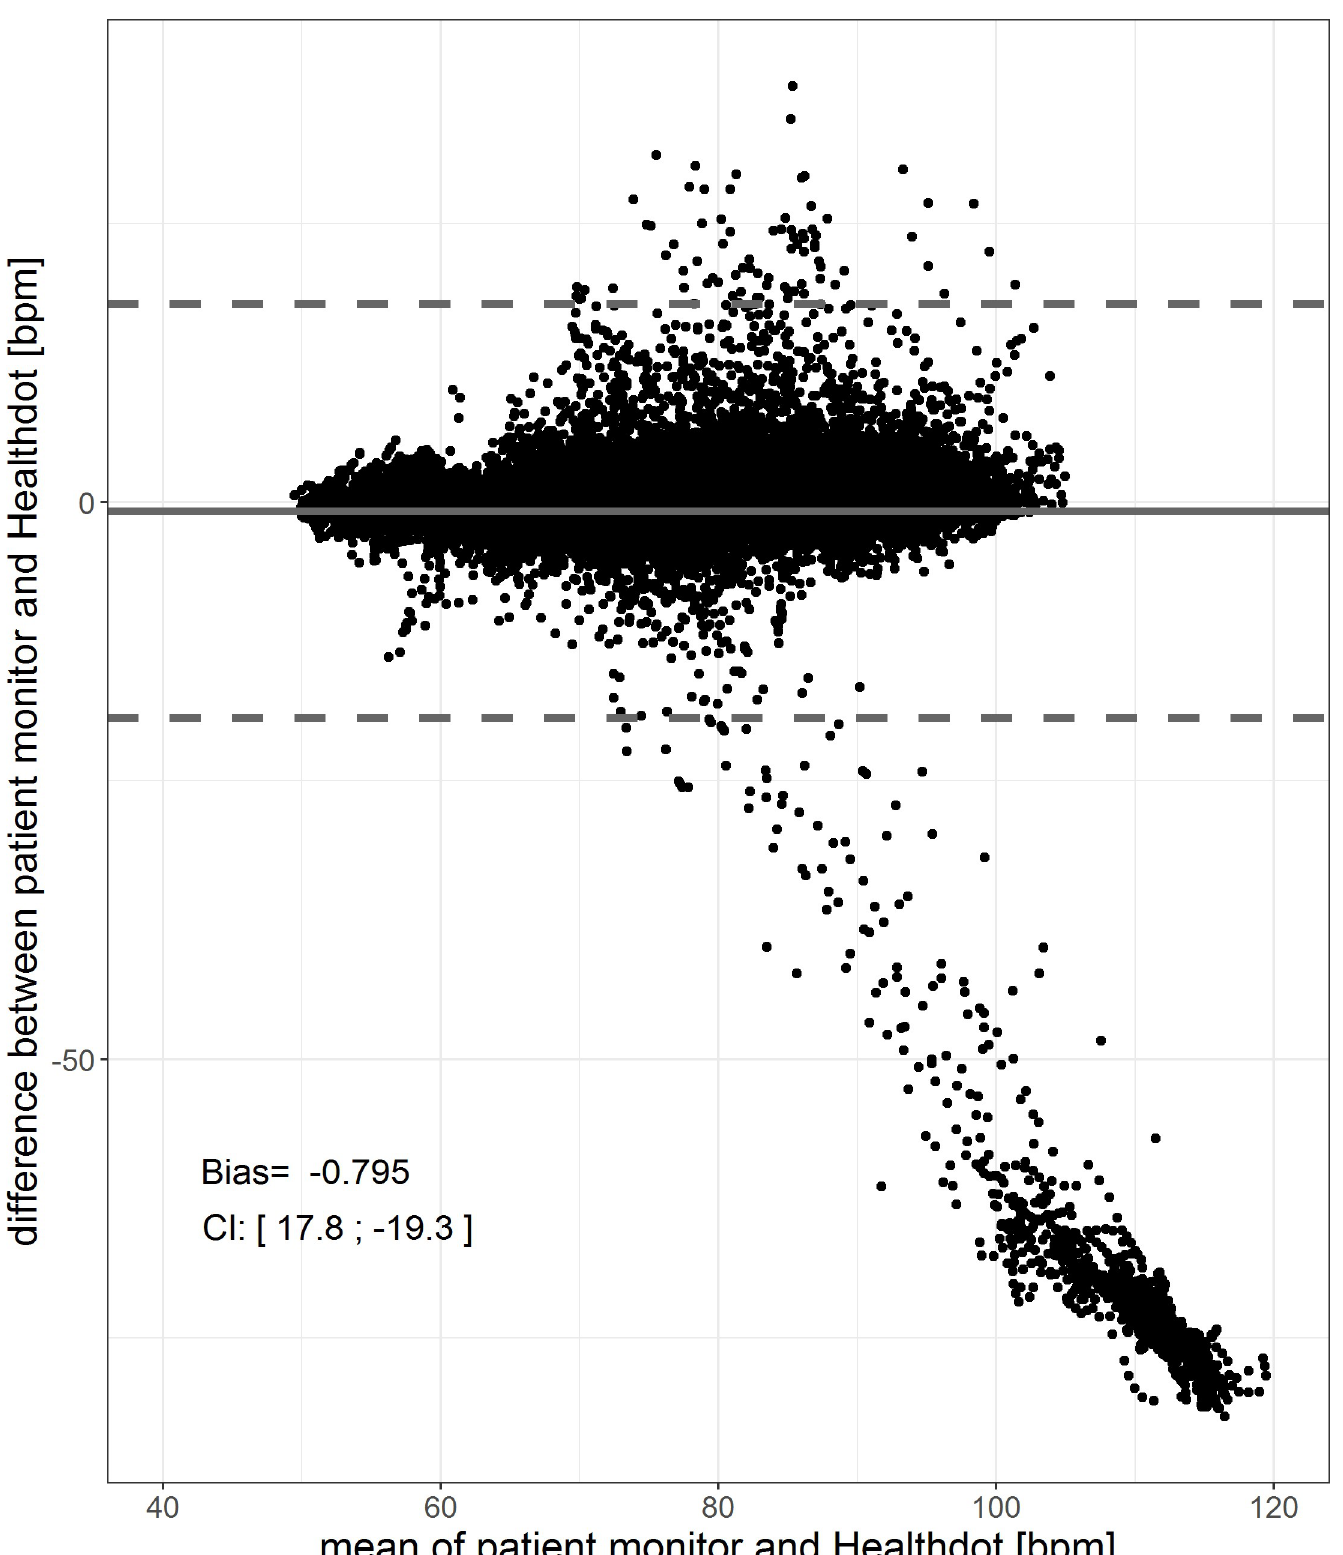
Fig 4. Bland-Altman plot of the HeartR. The difference between the two methods (Healthdot and patient monitor) is plotted against the average of the two, respectively on the y-axis and x-axis. The bias (-0.80 bpm) is indicated by the gray solid line and the confidence interval [CI: 17.8; -19.3 bpm] is indicated by the gray dashed